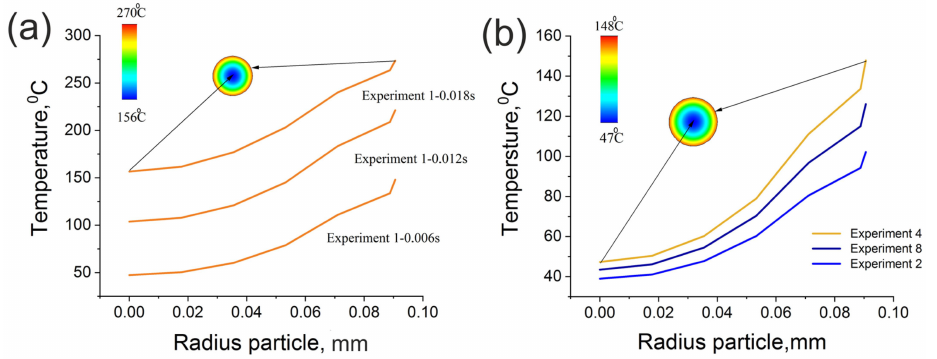
Figure 11. ( a ) Influence of the time factor on the heating of a UHMWPE particle at a constant temperature. ( b ) Influence of the temperature factor on particle heating at a constant heating time of 0.006 s.